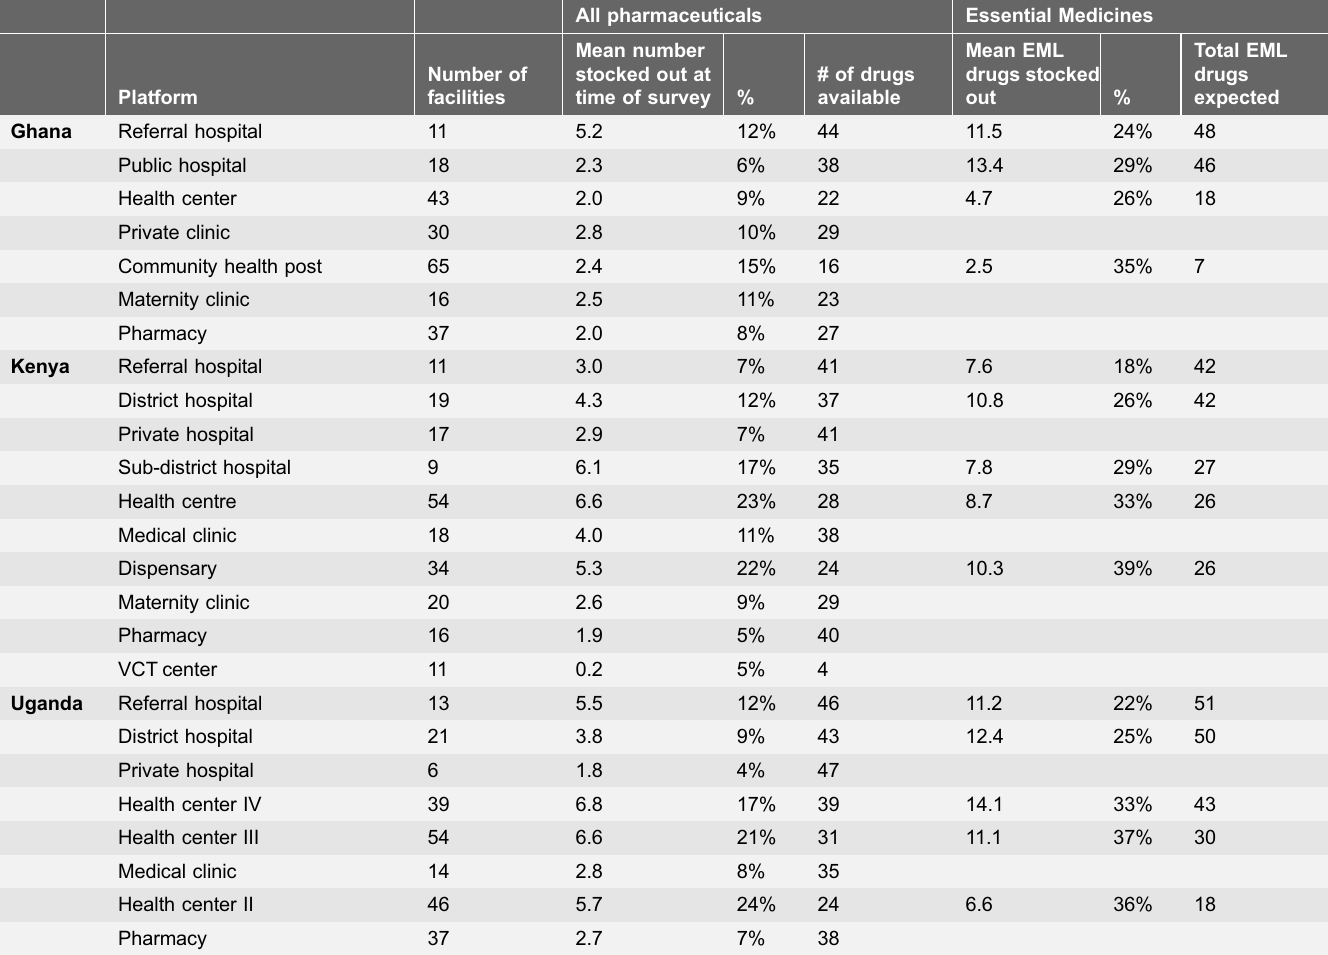
Table 1. Pharmaceutical availability by